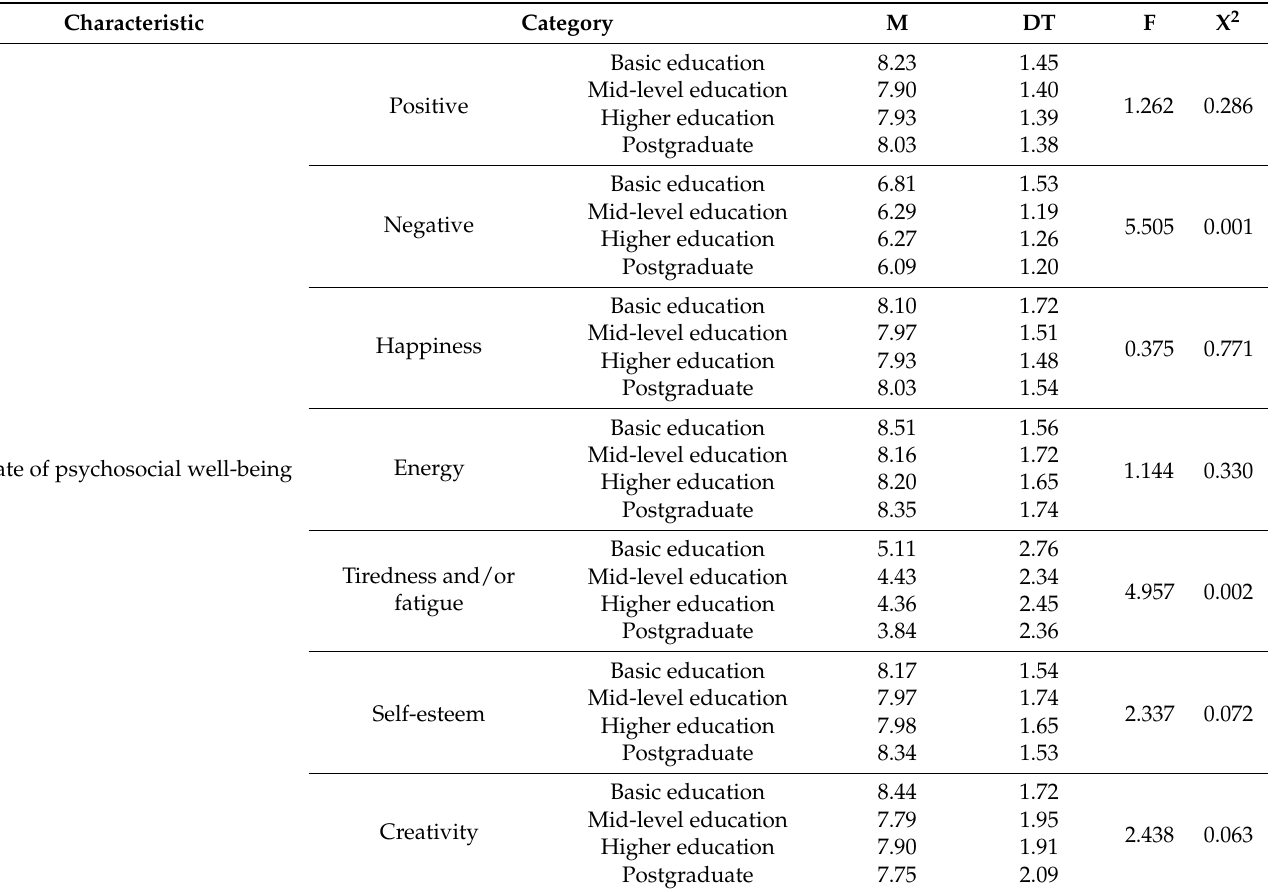
Table 10. State of psychosocial well-being according to the educational level of Ibero-American parents. Characteristic Category M DT F X 2